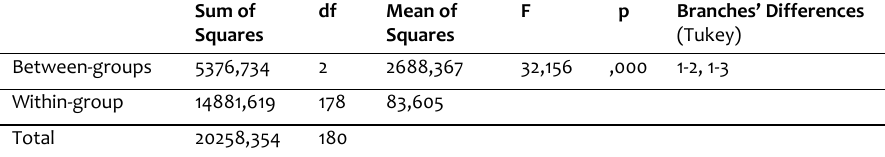
Table 8. One-way ANOVA test table on scores of teachers on attitude scale according to their scale of self- efficiancy in technology Sum of